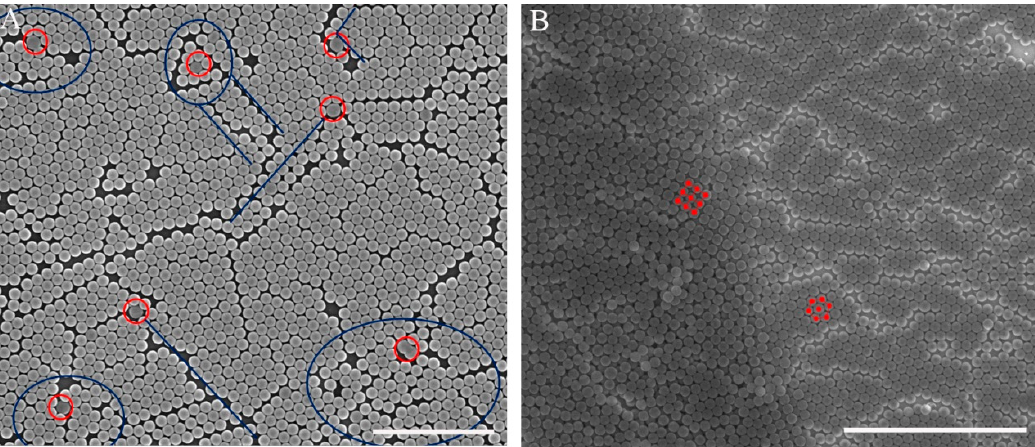
Figure 5. ( A ) Influence of defect precursors on monolayer colloidal crystal; ( B ) alignment boundary of monolayer and two layers. (Scale bar 3 μ m).